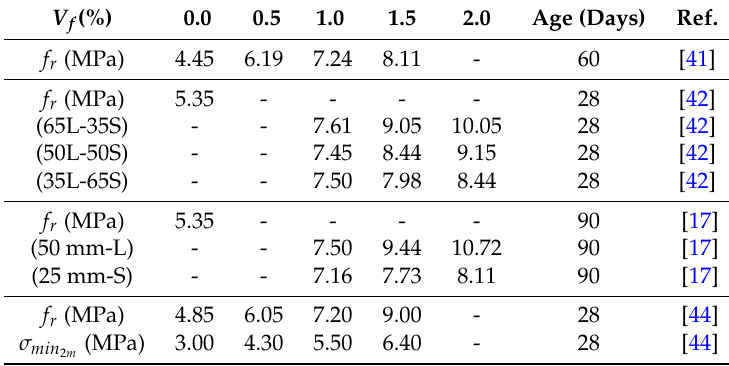
for the plain and 2 m